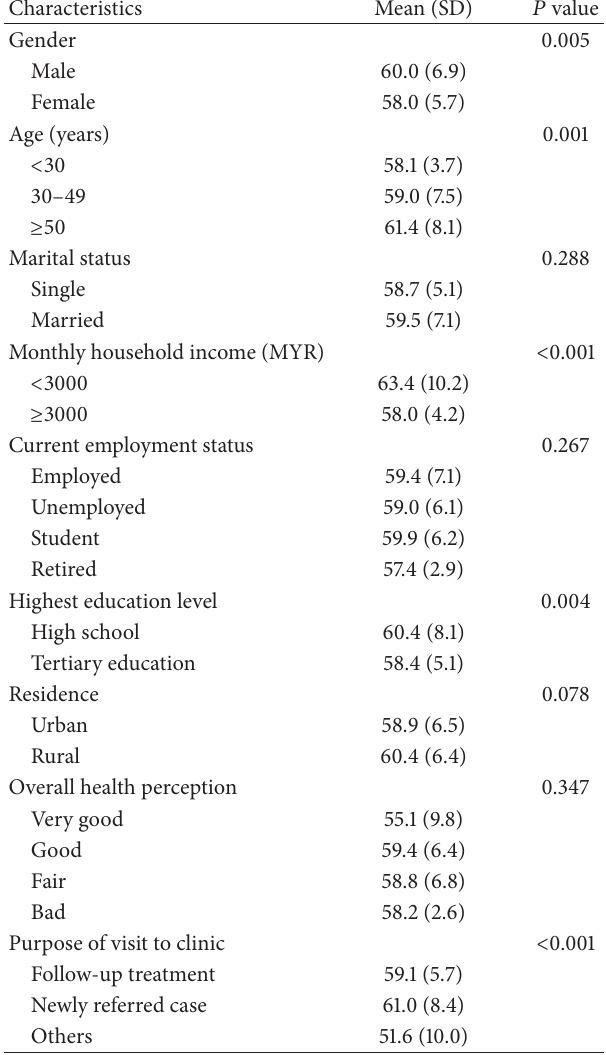
Table 3: Association between sample characteristics and health service satisfaction ( 𝑛 =